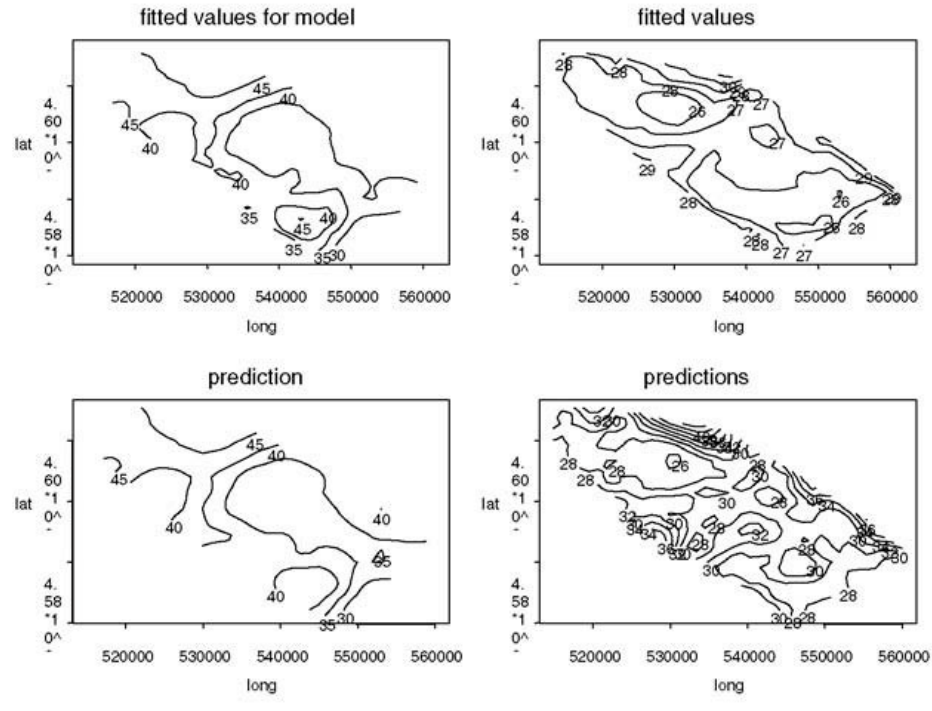
Figure 3 – Contourplots (based on a linear interpolation) of fitted values and predictions on a square grid for model VI and their